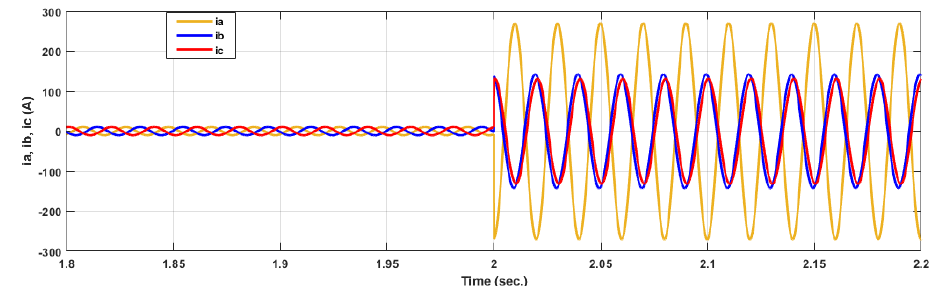
Figure 33. Current signals for 10% short circuit fault in phase a and phase b.